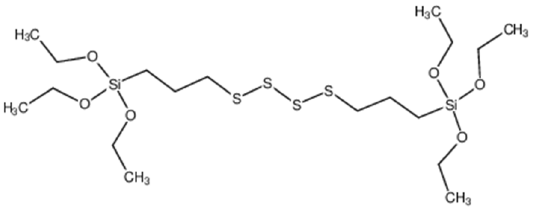
Figure 2. Silane-coupling agent TESPT (bis-[3-(triethoxysilyl)propyl]tetrasulfide).